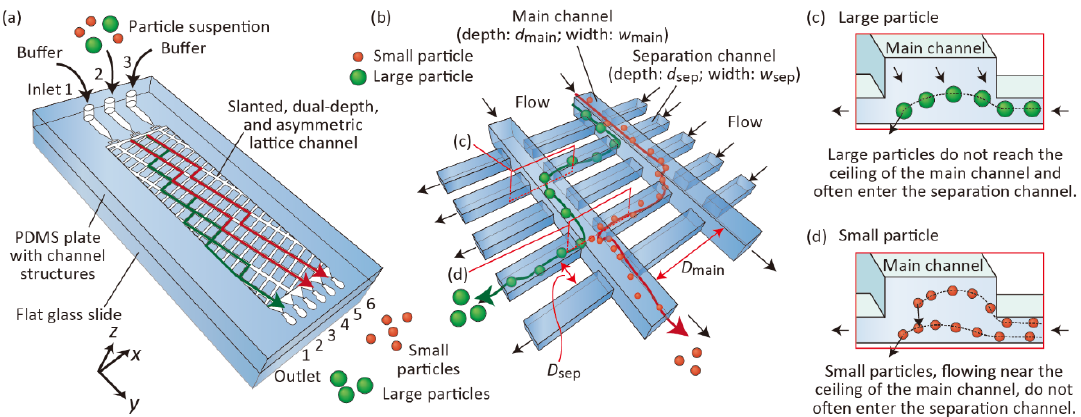
Figure 1. ( a ) Schematic image illustrating particle separation behaviors using dual depth, lattice-shaped channel networks. ( b ) Detailed behaviors of particles in the lattice region. ( c , d ) Illustrations showing the particle movement in the depth ( z ) direction from the shallower separation channels into the main channels. These images correspond to the cross sections shown in panel ( b